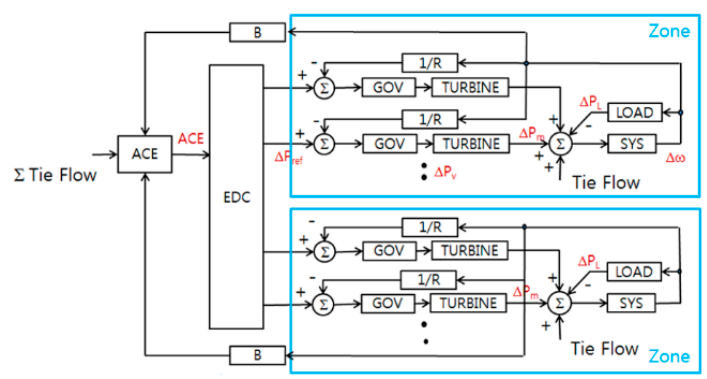
Figure 6. AGC configuration.